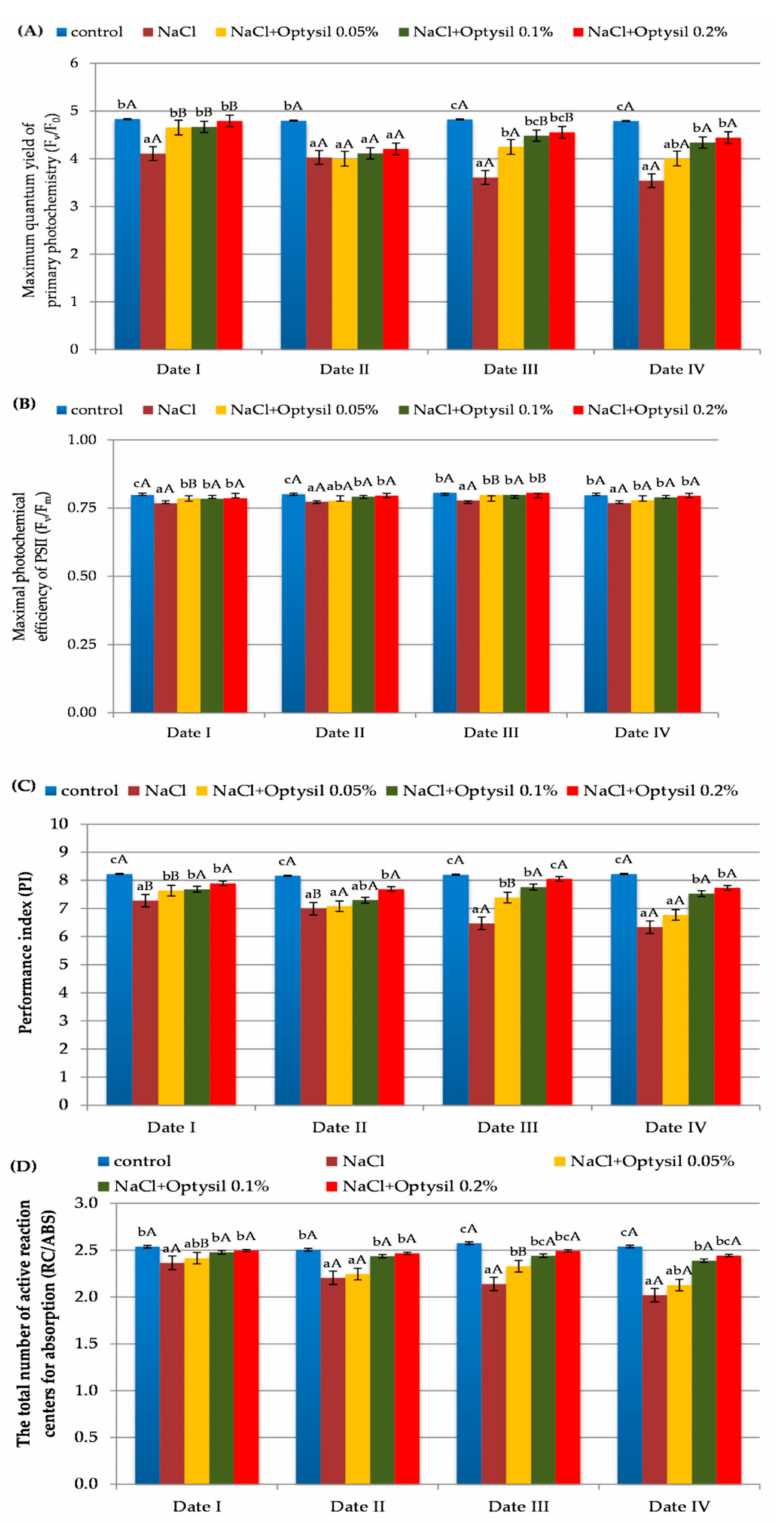
Figure 2. The effect of factors of experiment and measurement date on chlorophyll fluorescence parameters in oat plants (Date I and Date II, 2 and 7 days after first Si application; Date III and Date IV, 2 and 7 days after second Si application). Statistical data are expressed as mean ± SD values. Capital letters show significant differences between the means in the measurement dates, and lower case letters show significant differences between the means at next measurement dates ( p =